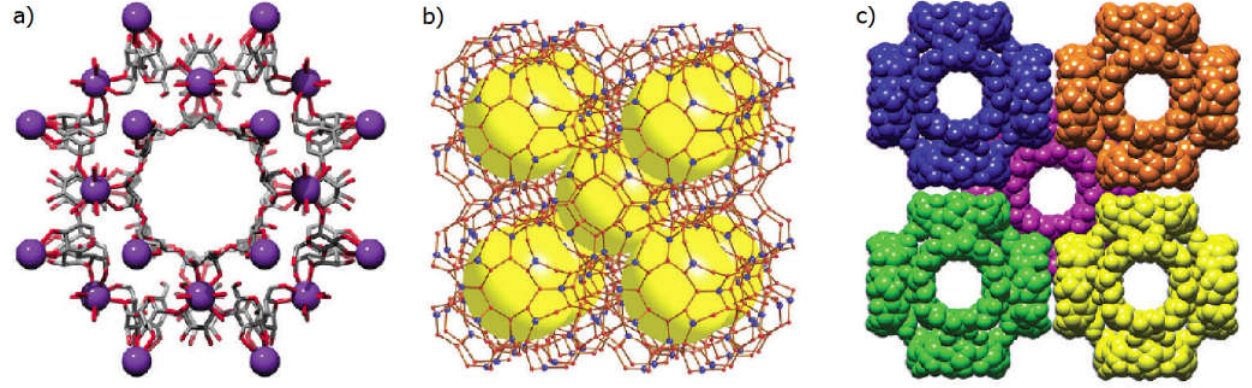
Figure 2. Representation of different aspects of the solid-state structure of the γ -CD-MOF with K + ions as metal centres: ( a ) one of the repeating ( γ -CD) 6 units, each having a 1.7 nm diameter cavity, with γ -CD units depicted in the stick model and K + ions as purple spheres; ( b ) representation highlighting the porous network comprised of various large spherical cavities at the centres of the ( γ -CD) 6 units, here depicted as large yellow spheres, while individual sugar units of the γ -CD ring are depicted by red spheres and the K + ions by blue spheres; ( c ) space-filling representation of the extended body-centred cubic packing, with each separate ( γ -CD) 6 units having a different colour to highlight the body-centred cubic packing arrangement. Reproduced with permission from Forgan et al . [32].